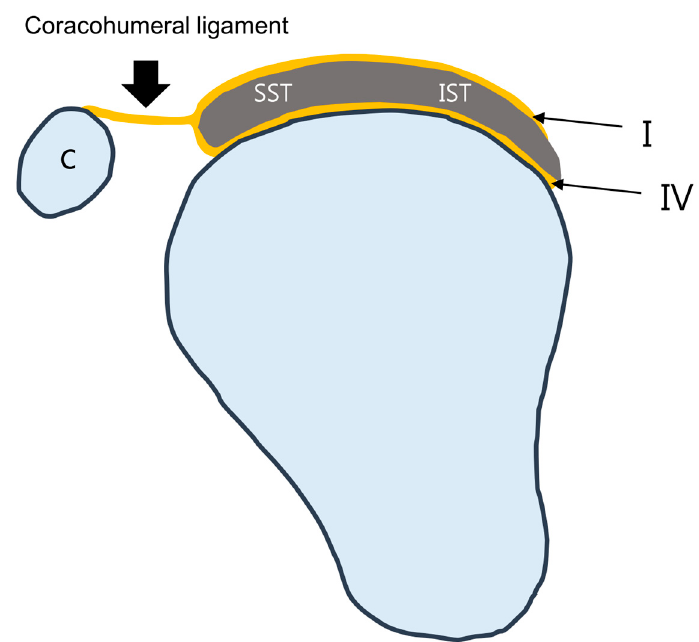
Figure 2. Schematic diagram of the coracohumeral ligament extension in the sagittal plane. The coracohumeral ligament has two extensions that course along the cuff tendons (layer I) and a deeper layer corresponding to the rotator cable (layer IV).